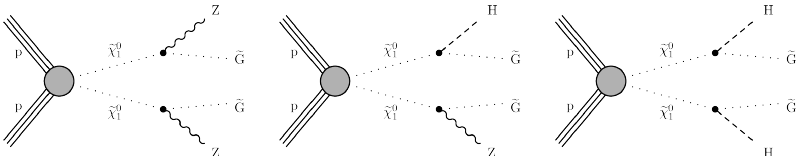
decaying to Z or Higgs bosons and ˜ G LSP [ 20 ] 1